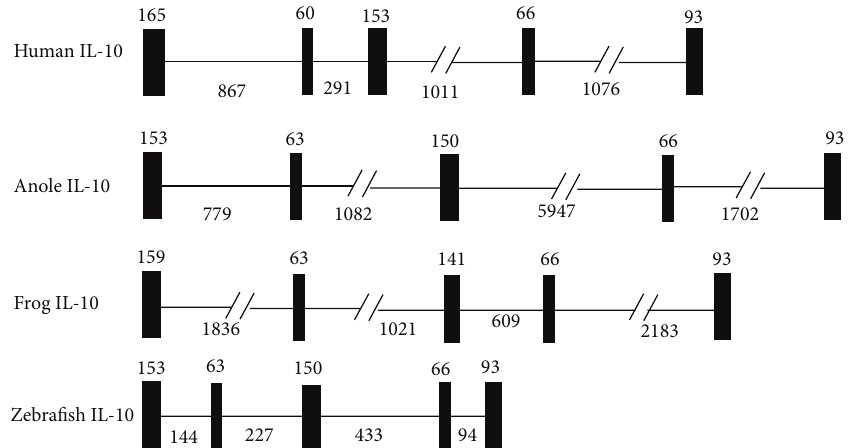
Figure 1: Comparison of the gene organization of frog IL-10 gene with selected IL-10 molecules. The exons were indicated as black boxes and introns as black lines. The numbers above each box indicate the size (bp) of exons and the numbers below the lines indicate the size (bp) of introns. The gene organization of each gene was extracted from Ensembl Genome database.